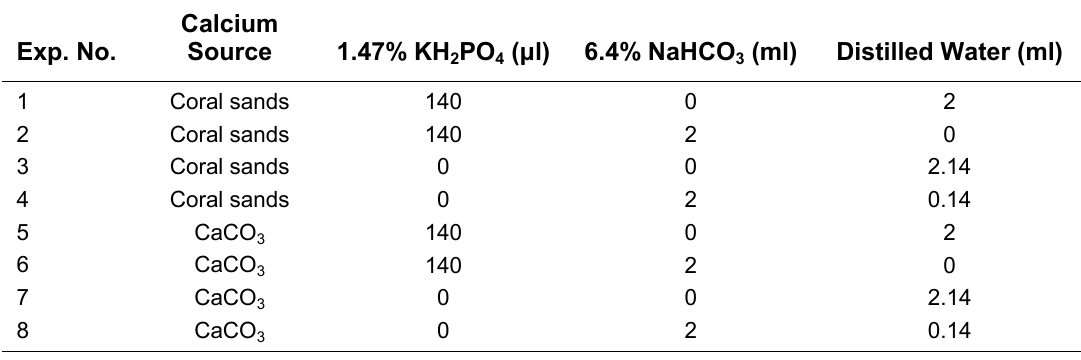
Medium Compositions in the Eight